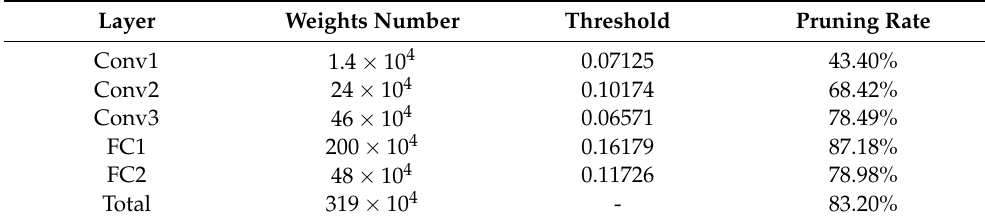
Table 3. Weight number, Threshold, and Pruning rate of different layers in source number estimation network.